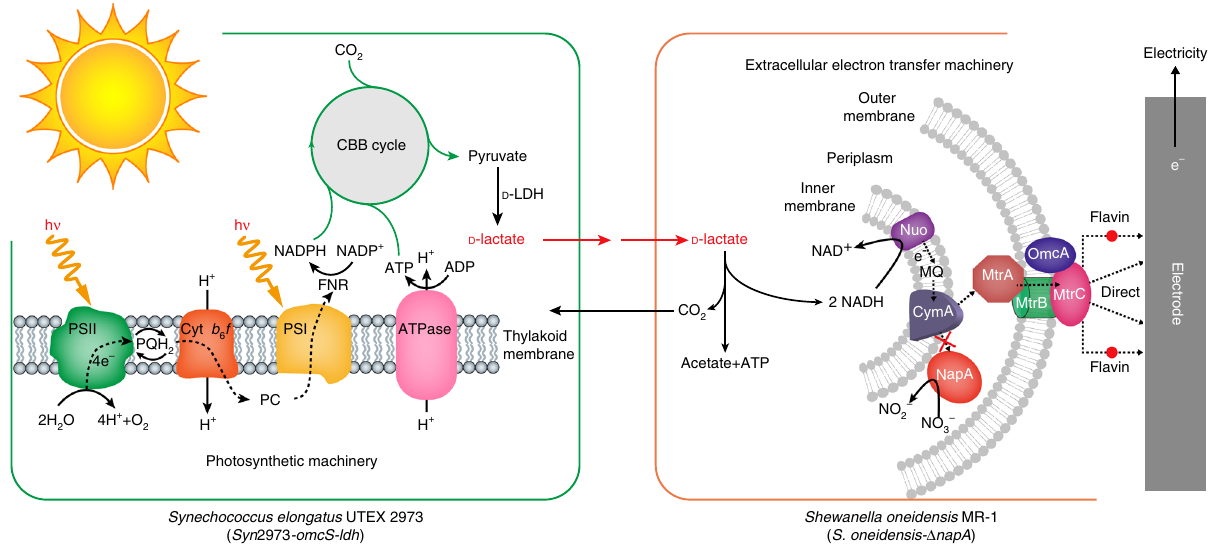
Fig. 1 Schematic diagram of the BPV system based on a two-species microbial consortium with constrained electron fl ow. The microbial consortium comprises an engineered cyanobacterium Synechococcus elongatus UTEX 2973 ( Syn 2973- omcS - ldh ) and an engineered Shewanella oneidensis MR-1 ( S. oneidensis - Δ napA ). Strain Syn 2973- omcS - ldh , equipped with the photosynthetic machinery and a D -lactate synthesis pathway, harvests light to perform H 2 O photolysis and generates high-energy electrons (e − ). The electrons are transferred and the subsequently generated NADPH and ATP are used for CO 2 fi xation and D -lactate production. Strain S. oneidensis - Δ napA , a napA deletion mutant, equipped with a D -lactate oxidation pathway and the EET machinery, releases electrons from D -lactate and transfers them to the anode for electricity production. The released CO 2 can be re-assimilated by cyanobacteria for D - lactate production. The dotted arrows show the routes of electron transfer in the photosynthetic machinery and EET machinery. PSI/II: photosystem I/II; PQH 2 : plastoquinol; Cyt b 6 f : cytochrome b 6 f complex; PC: plastocyanin; FNR: ferredoxin-NADPH reductase; ATPase: ATP synthase; CBB cycle: Calvin- Benson-Bassham cycle; D -LDH: D -lactate dehydrogenase; Nuo: NADH:ubiquinone oxidoreductase; MQ: menaquinone; CymA: an inner membrane tetraheme cytochrome c; MtrA: a periplasmic decaheme cytochrome c; MtrB: a non-heme outer membrane porin protein; MtrC/OmcA: two outer membrane decaheme c-type cytochromes; NapA: periplasmic nitrate